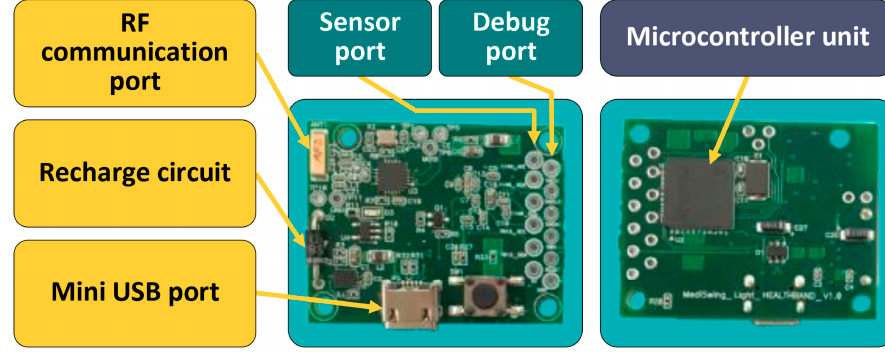
Figure 10. The developed PCB of wireless health monitoring (modified from [145]).